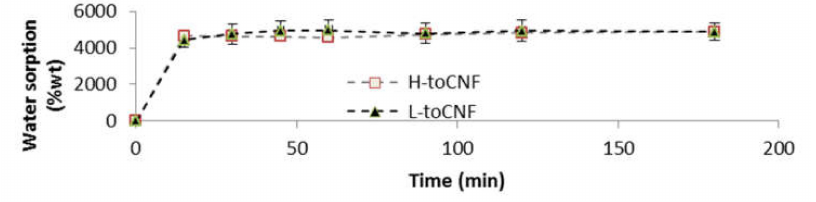
Figure 4. Water sorption for toCNF cryogels in immersion.